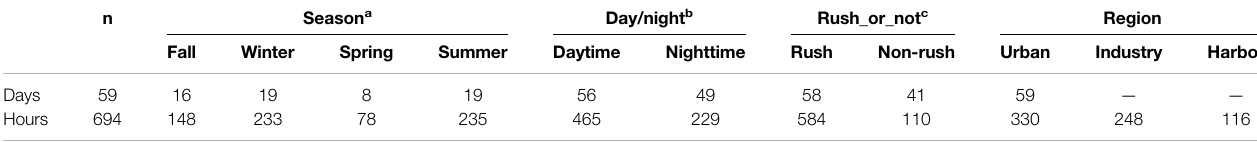
TABLE 2 | Description of the whole MMS sampling campaign classi fi ed into the whole sampling days/hours by the season, day/night, rush/non-rush, and area. n